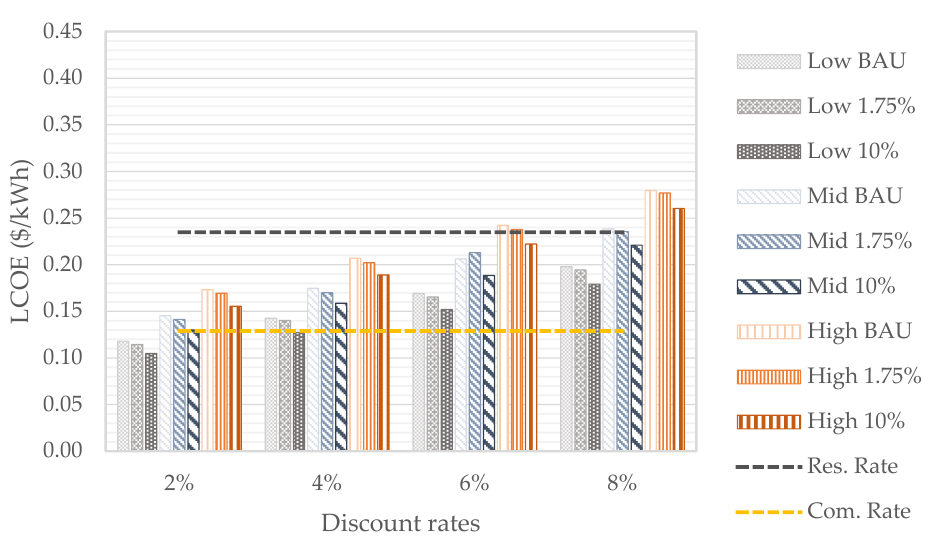
Figure 8. The sensitivity results for Negaunee with 45° tilt angle, different discount rate, varying components costs, and varying average load with and without energy efficiency considerations.